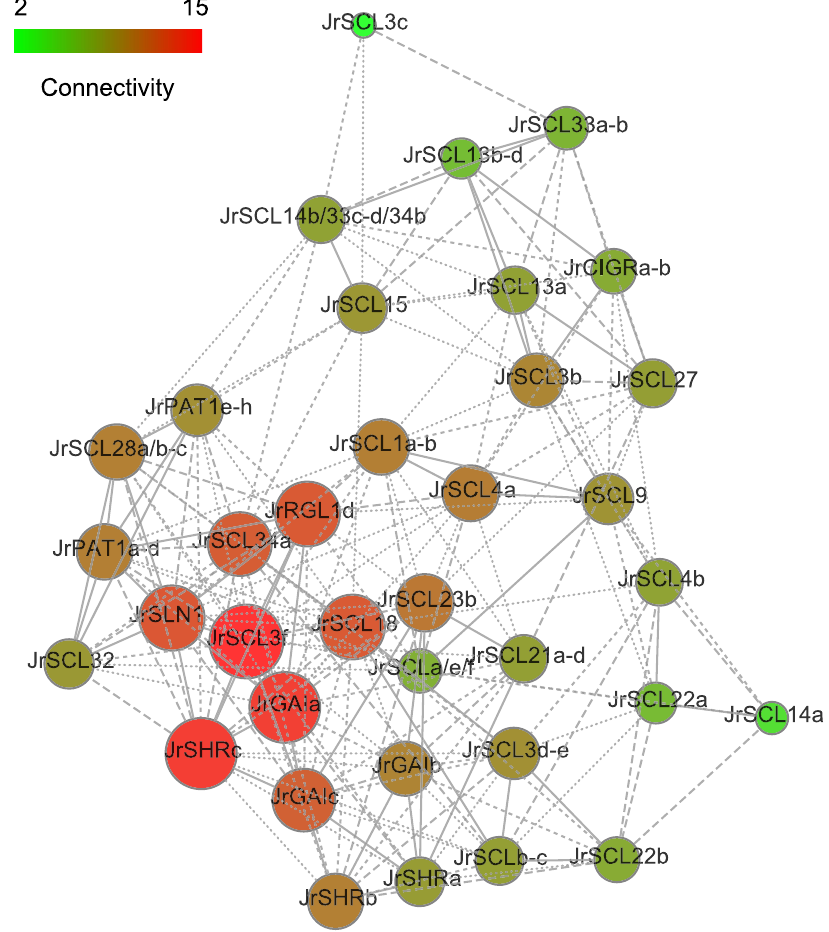
Figure 6. Co-expression networks of 58 JrGRAS genes. In the drawn weight network graph, the weight between genes will be divided into four parts, which are represented by point lines, short dotted lines, long dotted lines and real lines from small to large weights. The larger node and the redder color mean the greater connectivity of the gene in the network